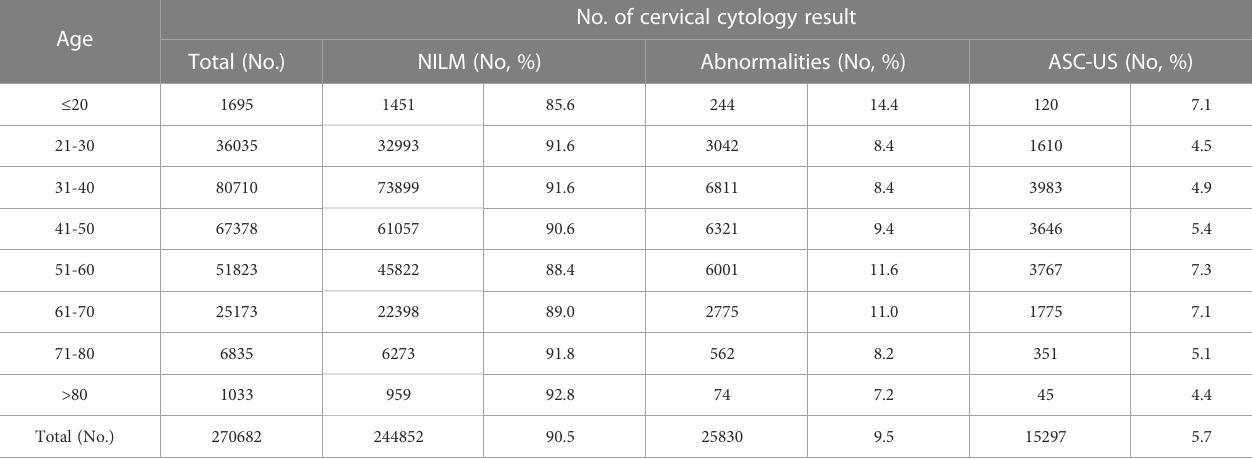
TABLE 1 Numbers of Cervical cytology result in different age groups.